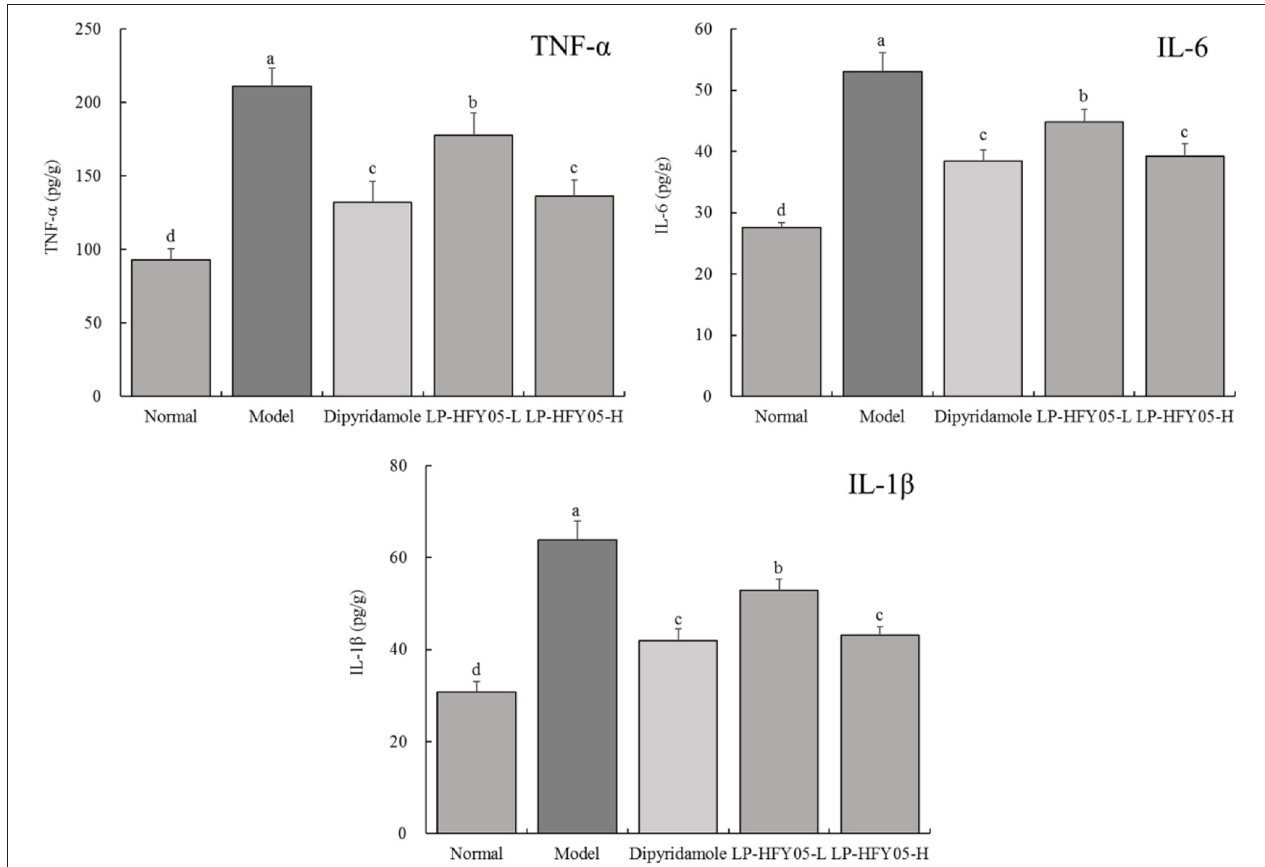
FIGURE 3 | TNF- α , IL-6, and IL-1 β levels in renal tissues of mice with thrombosis. a − d Mean values with different letters in the different bars were significantly different ( P < 0.05) according to the SNK multiple-range test; b, c, and d indicate significance vs the model group; the same letter of c indicates that there was no significant difference ( P > 0.05) between the two groups.